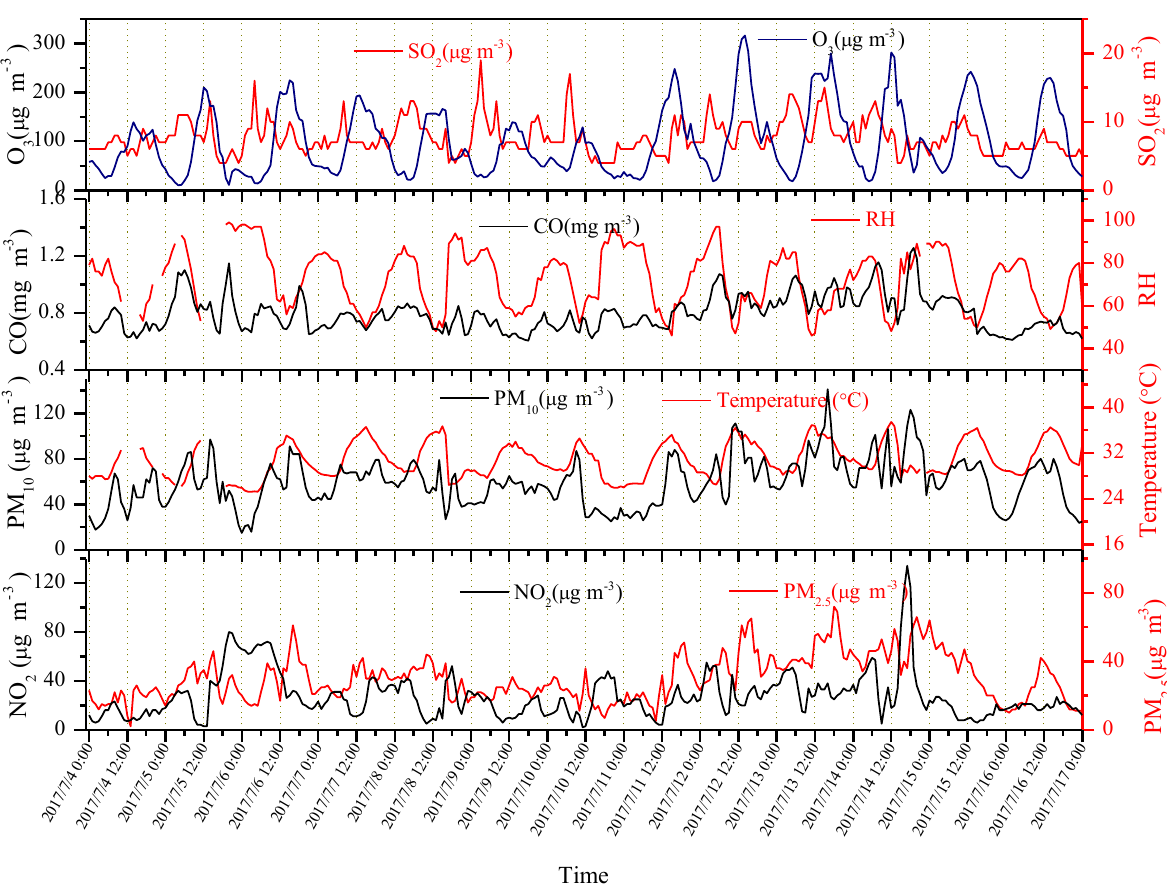
Figure 2. Temporal profiles of gaseous pollutants (O 3 , SO 2 , CO, and NO 2 ), temperature, relative humidity (RH), and PM 2 . 5 and PM 10 mass